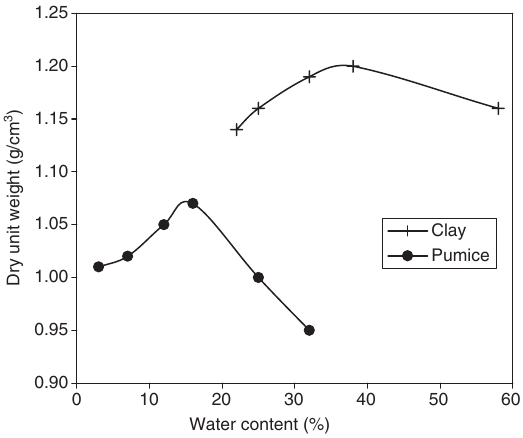
Figure 6 Results of standard compaction tests on the clay and pumice